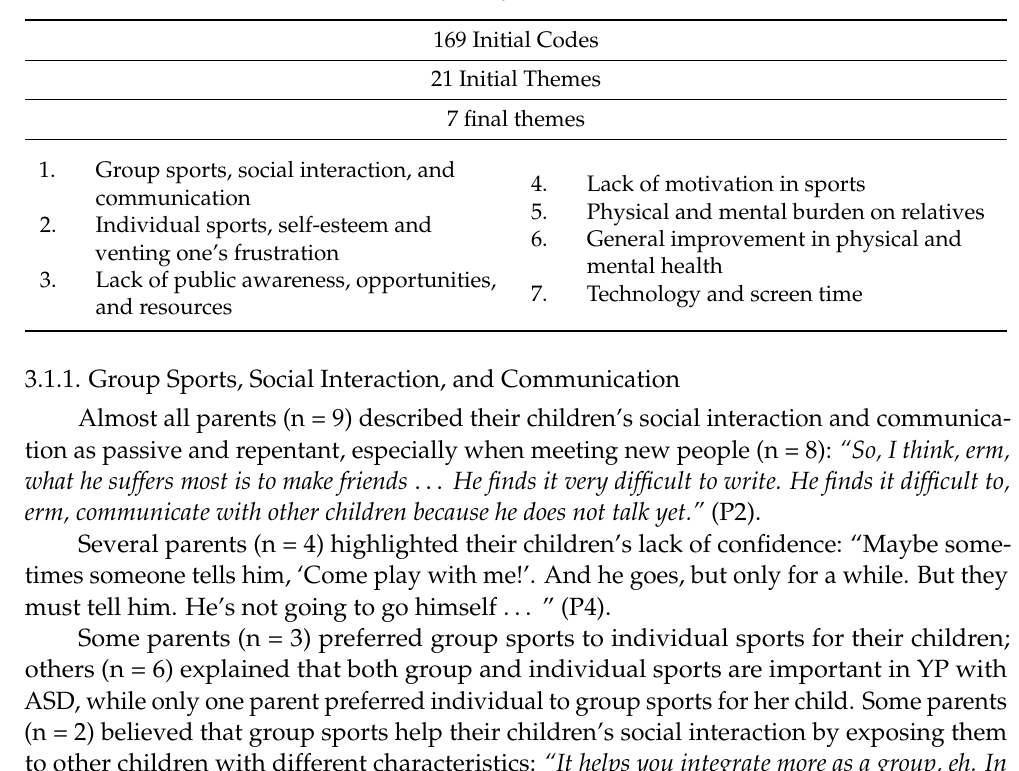
Table 2. Themes Generated from Thematic